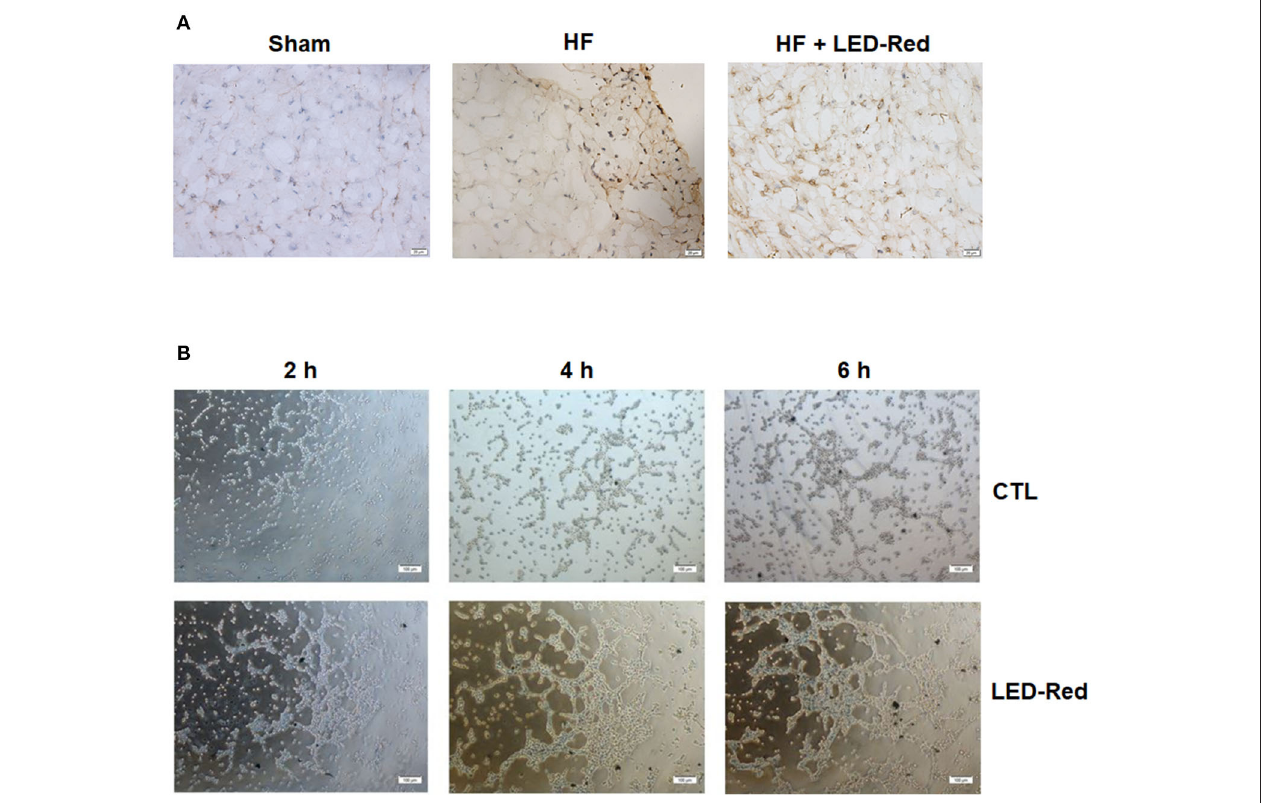
FIGURE 4 | LED-Red therapy promotes angiogenesis with heart failure. (A) Angiogenesis of heart in mice after HF by VWF immunohistochemical staining. Scale bar = 20 µ m. (B) Tube formation in CTL or LED-Red illuminated HUVECs. Scale bar = 100 µ